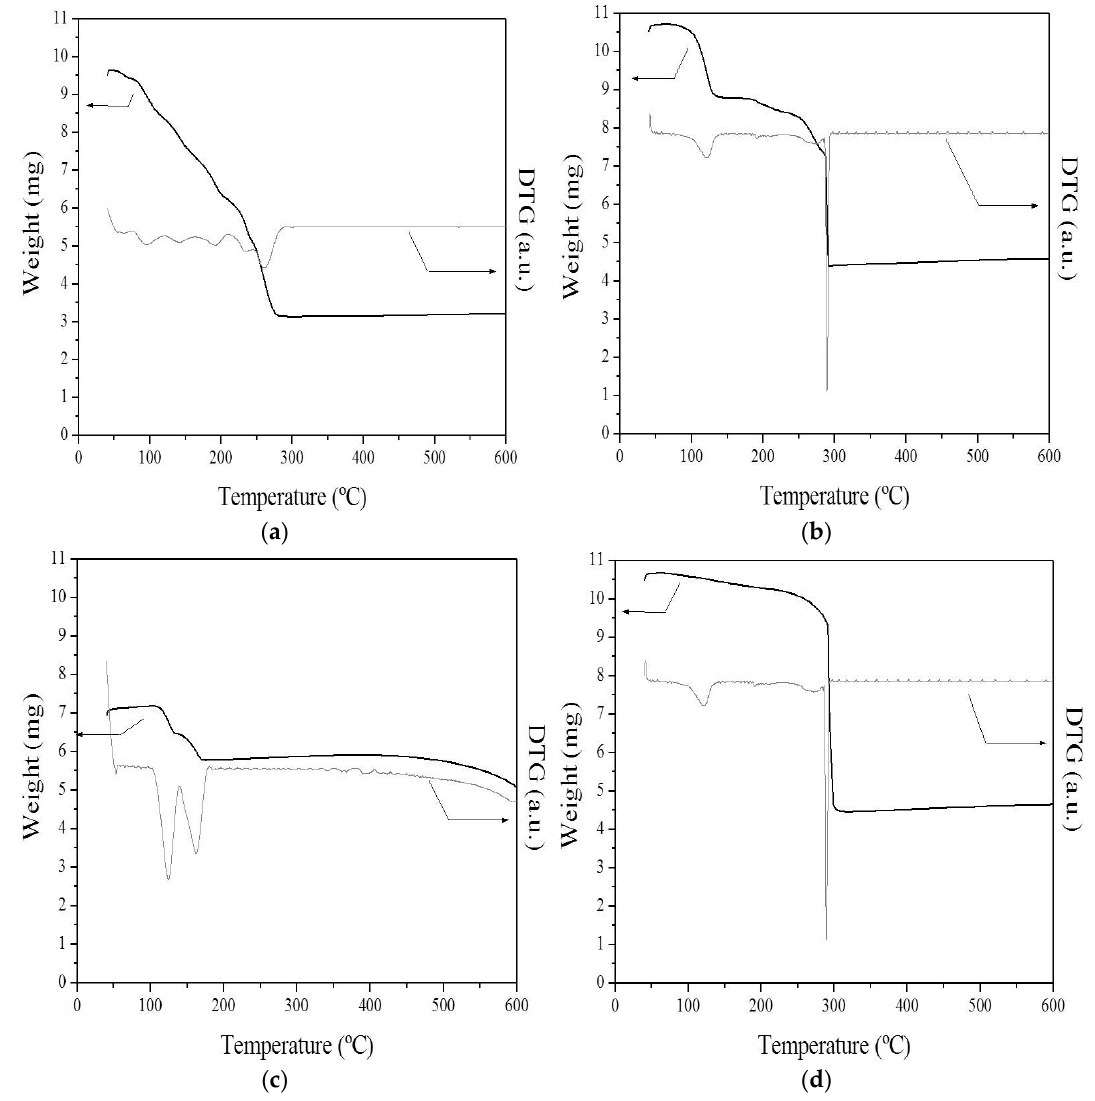
Figure 1. TG/DTG Co precursors: ( a ) CoN; ( b ) CoA; ( c ) CoCl; and ( d ) CoCit.